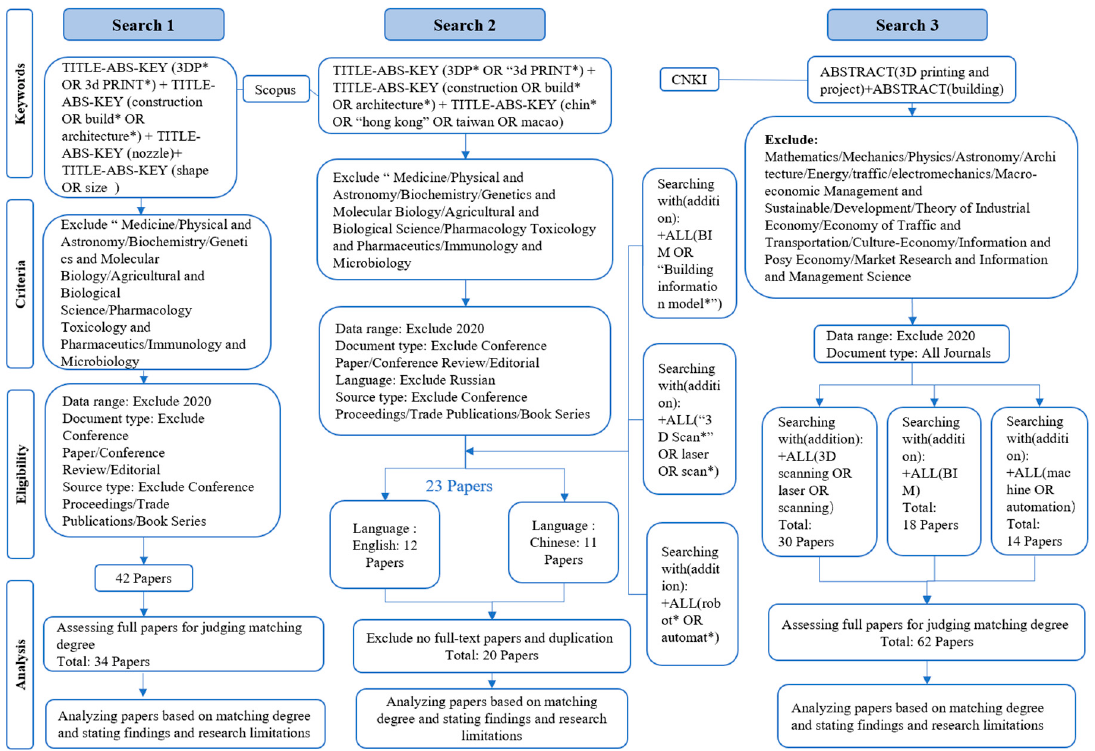
Figure 2. Flowchart for identifying relevant papers in Scopus and CNKI, based on preferred reporting items for systematic reviews and meta-analyses (PRISMA) approach.